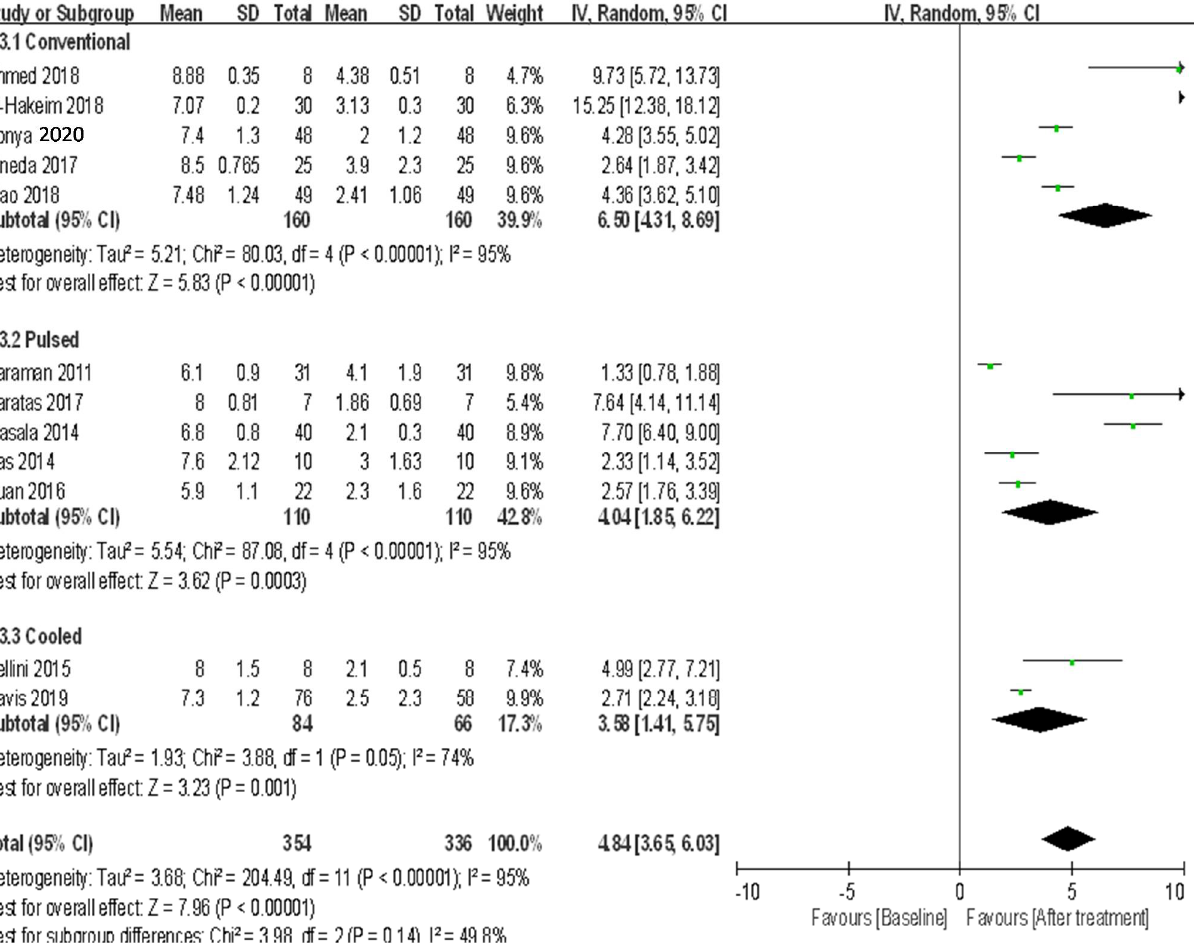
Figure 5. Meta-analysis of efficacy in pain using two radiofrequency ablation techniques to treat knee OA at the 12-month follow-up.